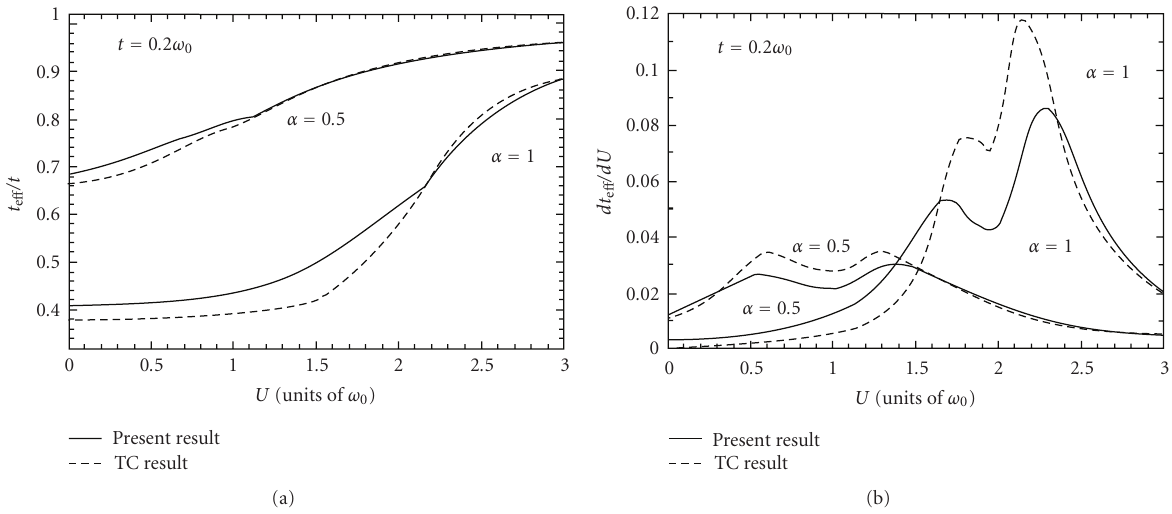
Figure 9: t e ff and its derivative as a function of U for two values of α and for t = 0 . 2 ω 0 . The TC results are shown for comparison.